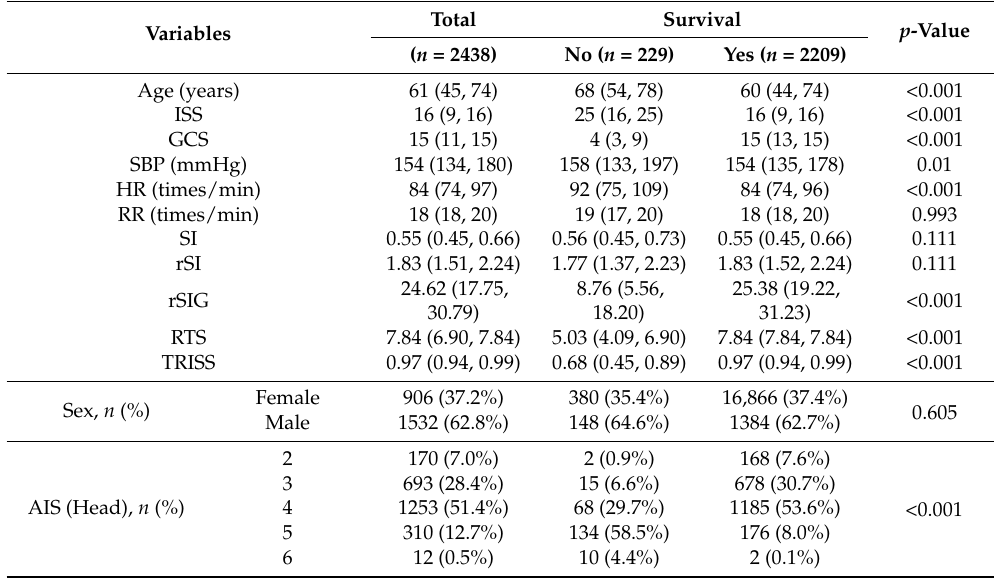
Table 2. Characteristics variables of patients with head